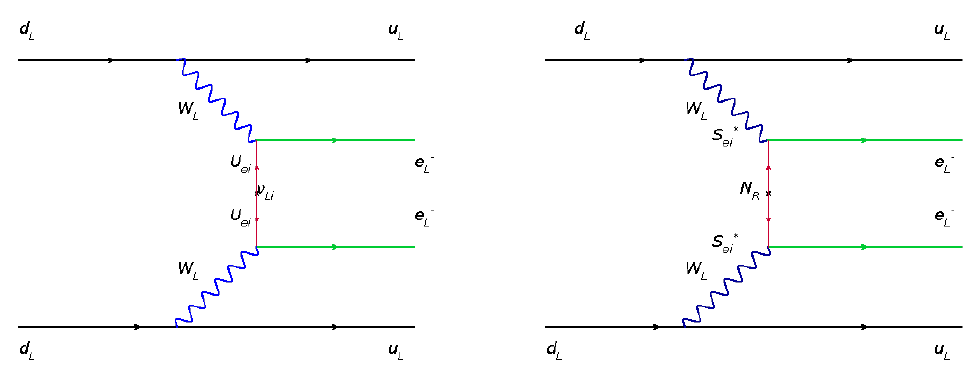
Figure 1 . Feynman diagrams corresponding to neutrinoless double beta decay due to (cid:23) (cid:0) W L (cid:0) W L , N (cid:0) W L (cid:0) W L